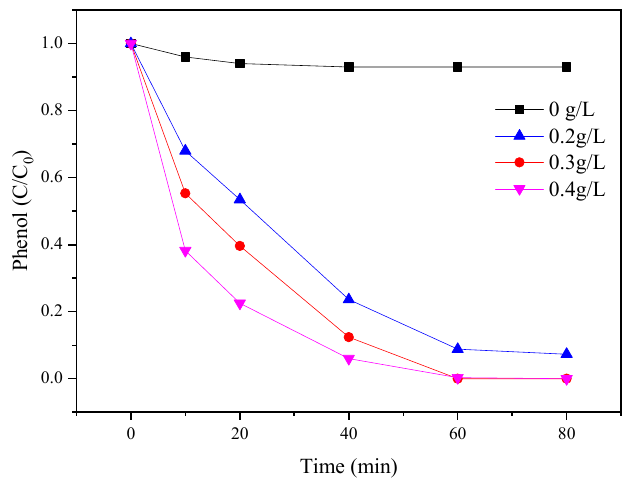
Figure 4. Effects of catalyst dosage on the PMS/CoMgAl-LDH system during phenol degradation.